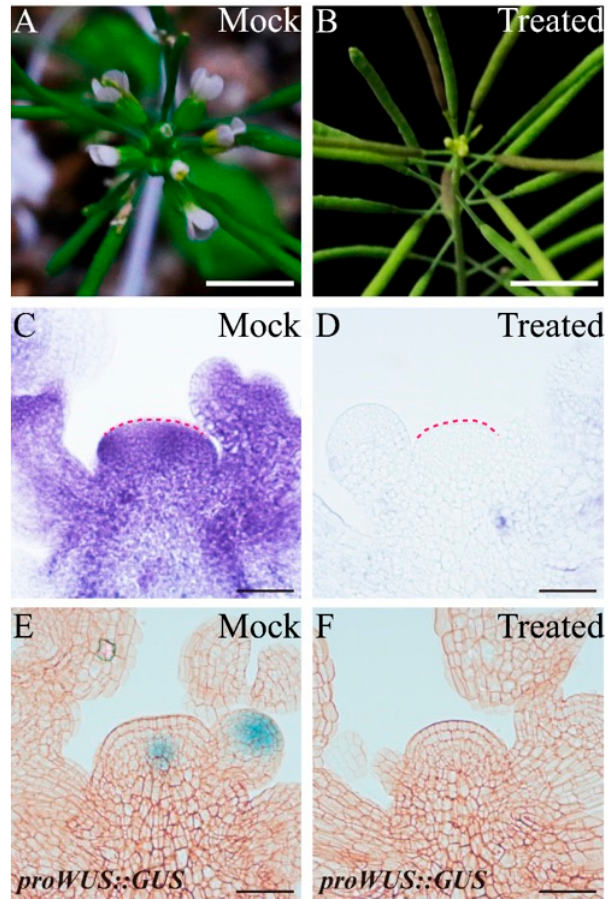
Figure 8. The phenotype of primary shoot inflorescence ( A , B ), O 2·- accumulation ( C , D ), and WUS expression pattern ( E , F ) of the control group (mock) and 20 mM DMTU-treated group. Pink dotted lines indicate the shape of the IM. Scale bars: 1 cm in ( A , B ), 25 μ m in ( C – F ).